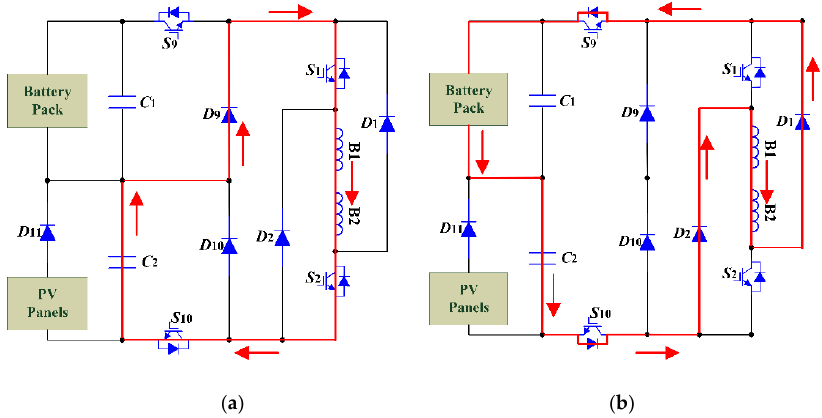
Figure 7. The PV panels provide energy to phase ( a ) windings. ( b ) The winding current of phase A is fed back to the battery pack.